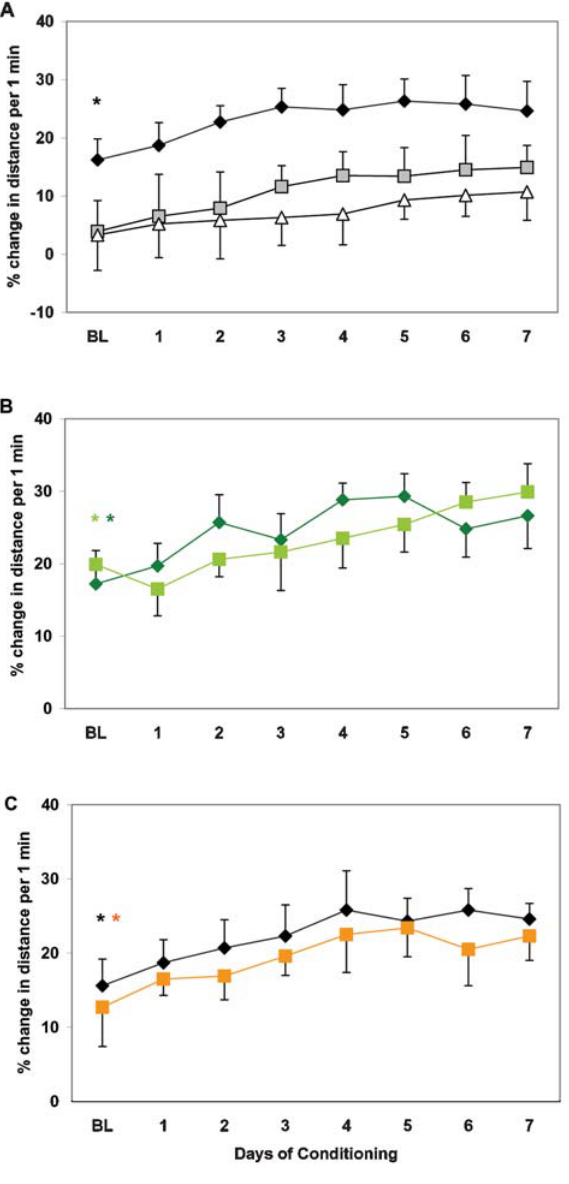
Figure 2. Development of anticipatory increase in locomotor activity prior to food administration in wildtype (A) and ACHE mutants (B) of different age, and in IR zebrafish (C). X-axis: % change in activity level within 30 min prior to food administration, as compared to preceding 90-min period. First day of significant (p , .05) change in group behavior in young (*) and middle-aged (**) fish. Note that BL was assessed after 7 days of new timing of daily food administration in white/white environment. Young fish – diamond, middle-aged fish – square, old fish – triangle. Wildtype – black; ACHE mutants – green; IR zebrafish –